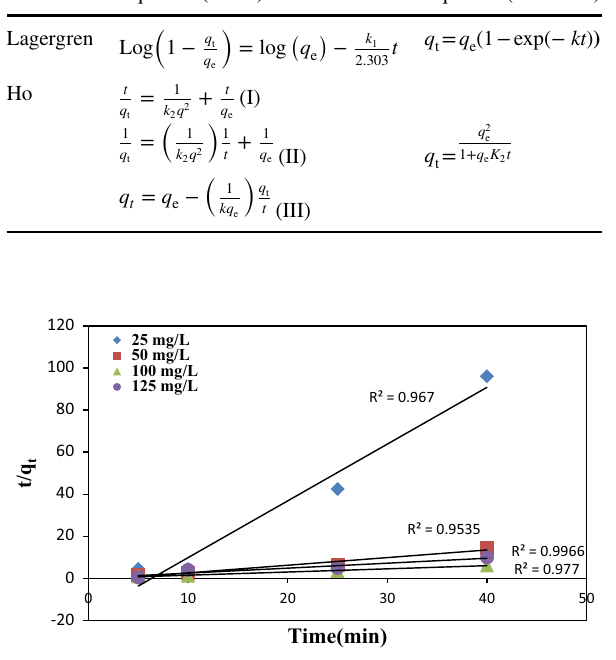
Fig. 4 Fitting of the Lagergren linear model with the adsorption kinetic data Table 2 The equations of kinetics used in the study Equation (linear) Equation (nonlinear)